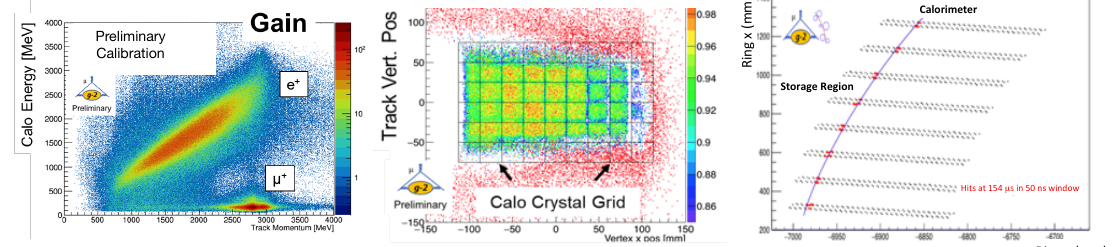
Figure 5. ( Left) Muon and positron discrimination from tracker data; ( Middle ) an imaging of the calorimeters from extrapolation of positron tracks from the tracker; and ( Right ) a positron hits in the tracker